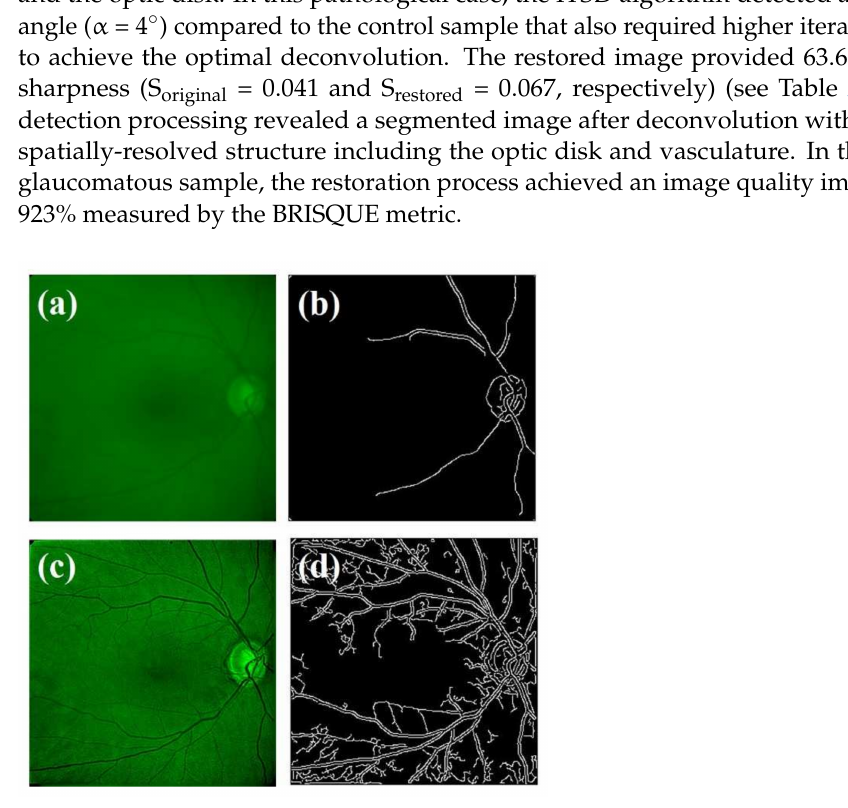
Figure 11. Original image from a glaucomatous eye. ( a ) Edge segmentation of original image. ( b ) Restored image ( c ) and edge segmentation of restored image ( d